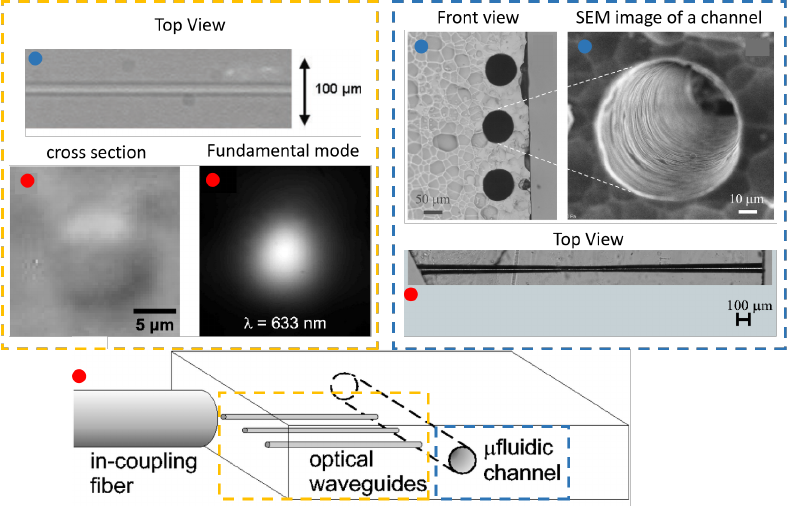
Figure 28. Femtosecond fabricated optofluidic platform for parallel multiple sensing at different positions in the micro channel. Details of channels and waveguides that can be fabricated in glass using femtosecond laser processing are illustrated separately. These images are adapted from multiple works of Bellini and Osellame using similar device formation. Marked with a red dot [164]. Marked with a blue dot [165]. Adapted from [164,165], with the permission of AIP Publishing.